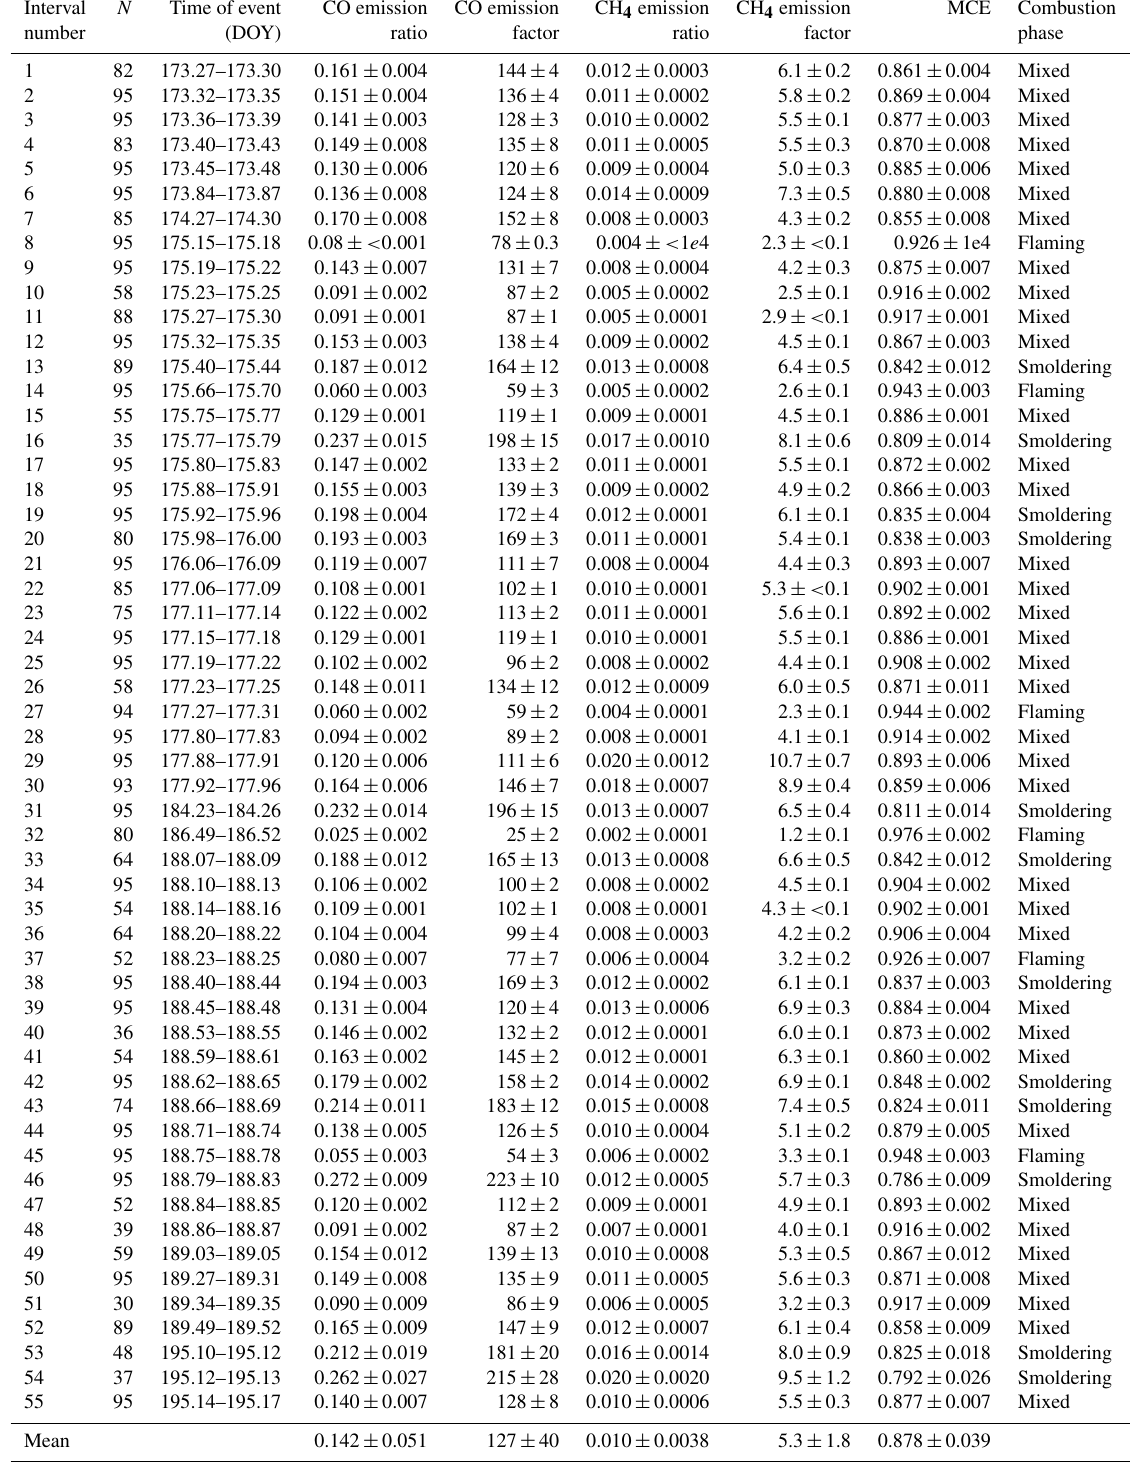
Table 2. Intervals with elevated trace gas mole fractions at CRV associated with fire emissions. Columns show the number of 30s mea- surements used to calculate emission factors for each interval ( N ), the time of the interval (units of day of year (DOY)), emission ratios cess is denoted as flaming, mixed, or smoldering using thresholds on MCE defined in the